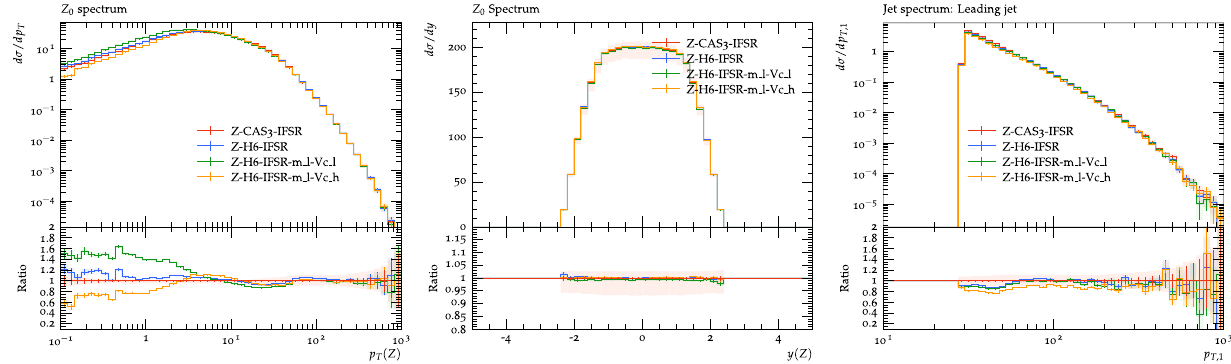
Fig. 9 Comparison of predictions obtained with MCatNLO+CAS3 and MCatNLO+H6 for Z production obtained with MCatNLO. Shown are predictions using initial state parton shower. The band of MCatNLO+CAS3 shows the uncertainties obtained from scale variation (as described in the